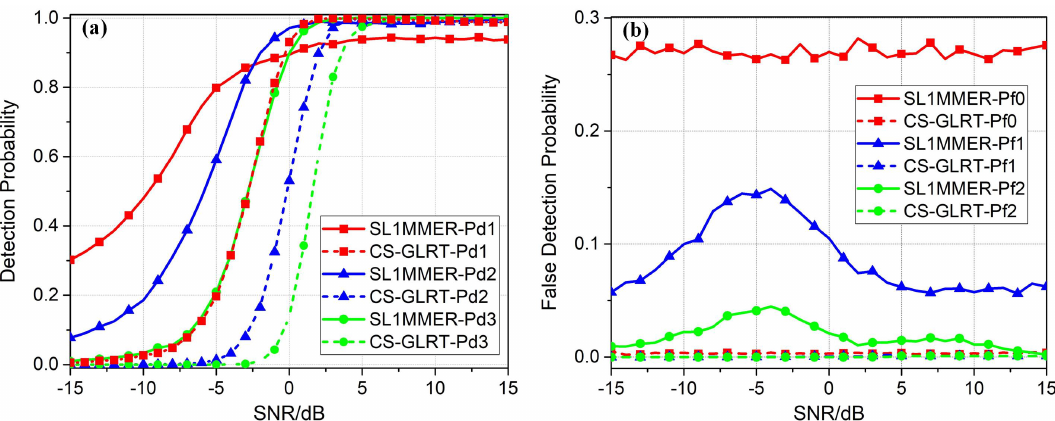
Figure 15. Detection characteristics of SL1MMER (solid) and CS-GLRT (dashed): ( a ) correct detection probability of single scatterer ( P d 1 , red, square), double scatterers ( P d 2 , blue, triangle), and triple scatterers ( P d 3 , green, circle); and ( b ) false detection probability with P f 0 (red, square), P f 1 (blue, triangle), and P f 2 ( green, circle).